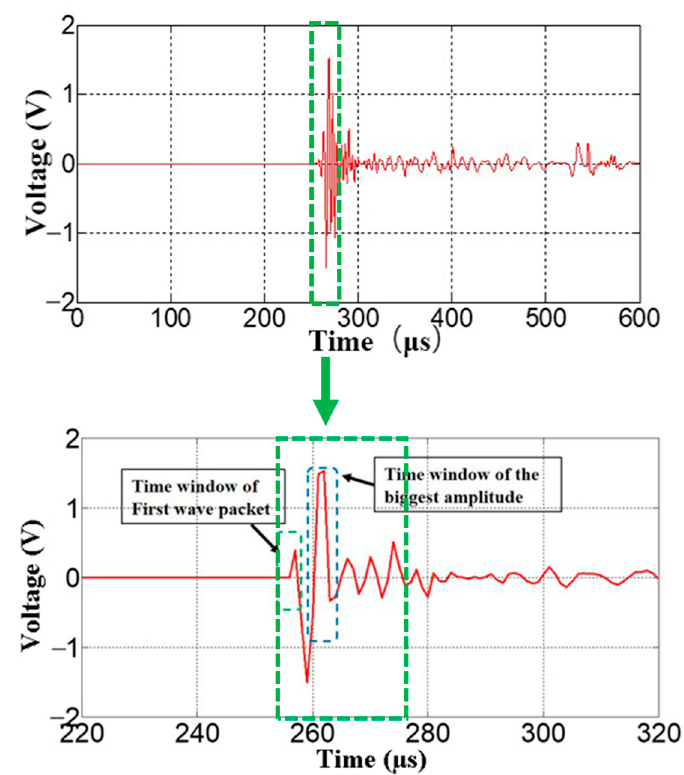
Figure 5. Local detail extraction of the signal inside the green box line.